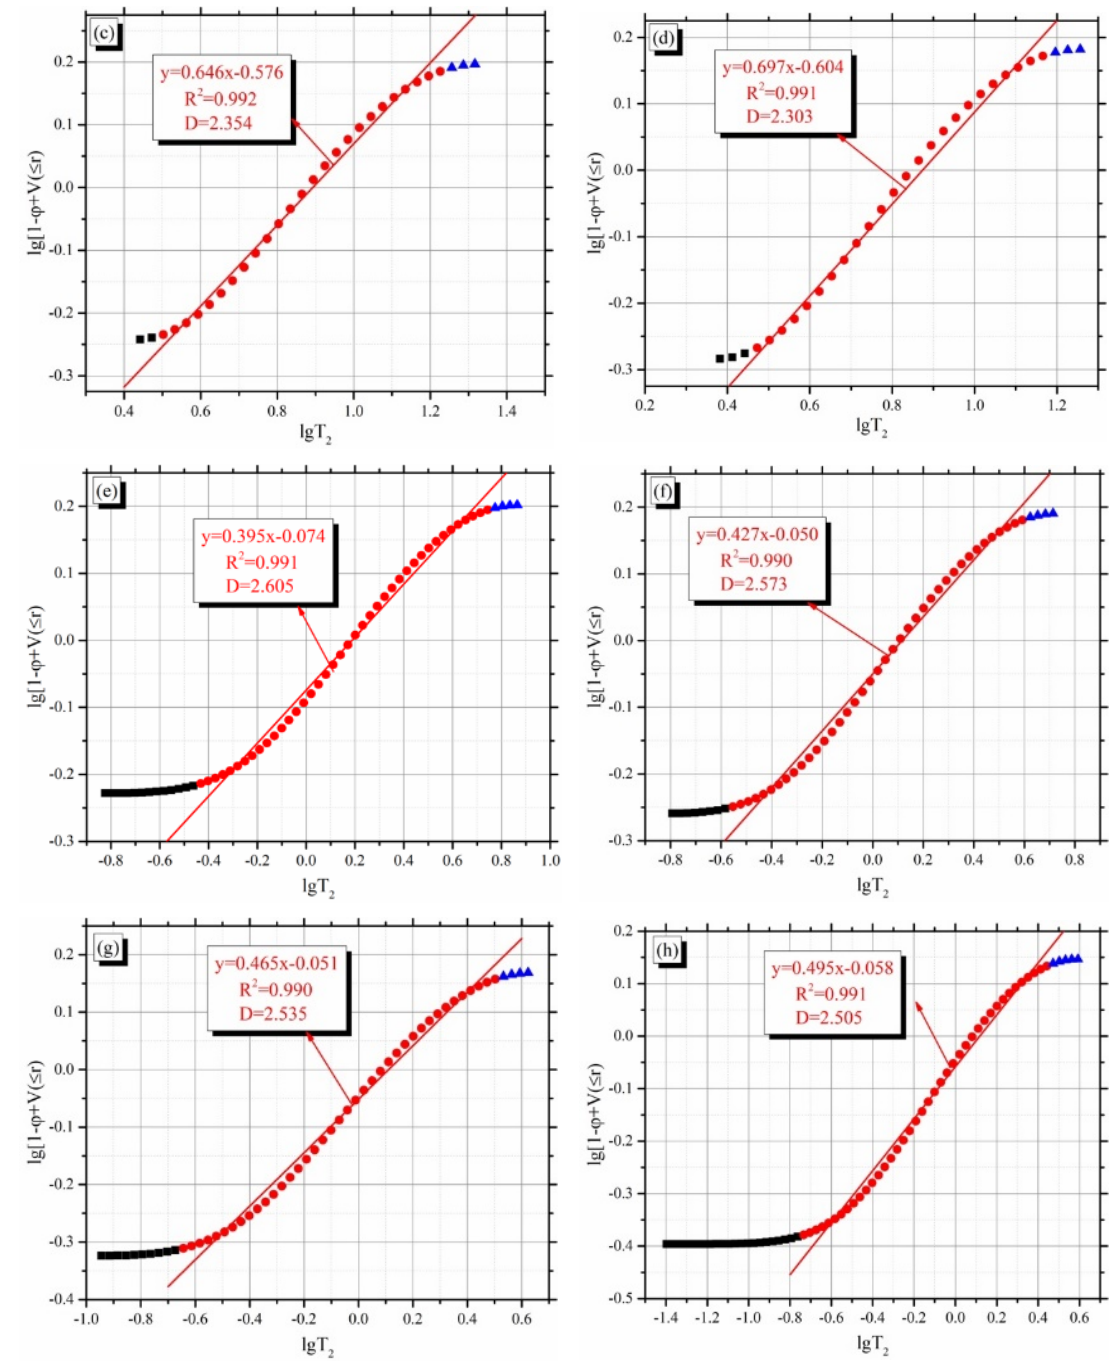
Figure 13. The fractal dimensions ( D ) of the eight mixtures: ( a ) K40; ( b ) K60; ( c ) K80; ( d ) K100; ( e ) M40; ( f ) M60; ( g ) M80; ( h ) M100. The red solid line is the fitting line of the red circular point. The Equation in the box is the Equation of the line. R 2 indicates the correlation coefficient of the Equation. D was calculated by Equation (11).